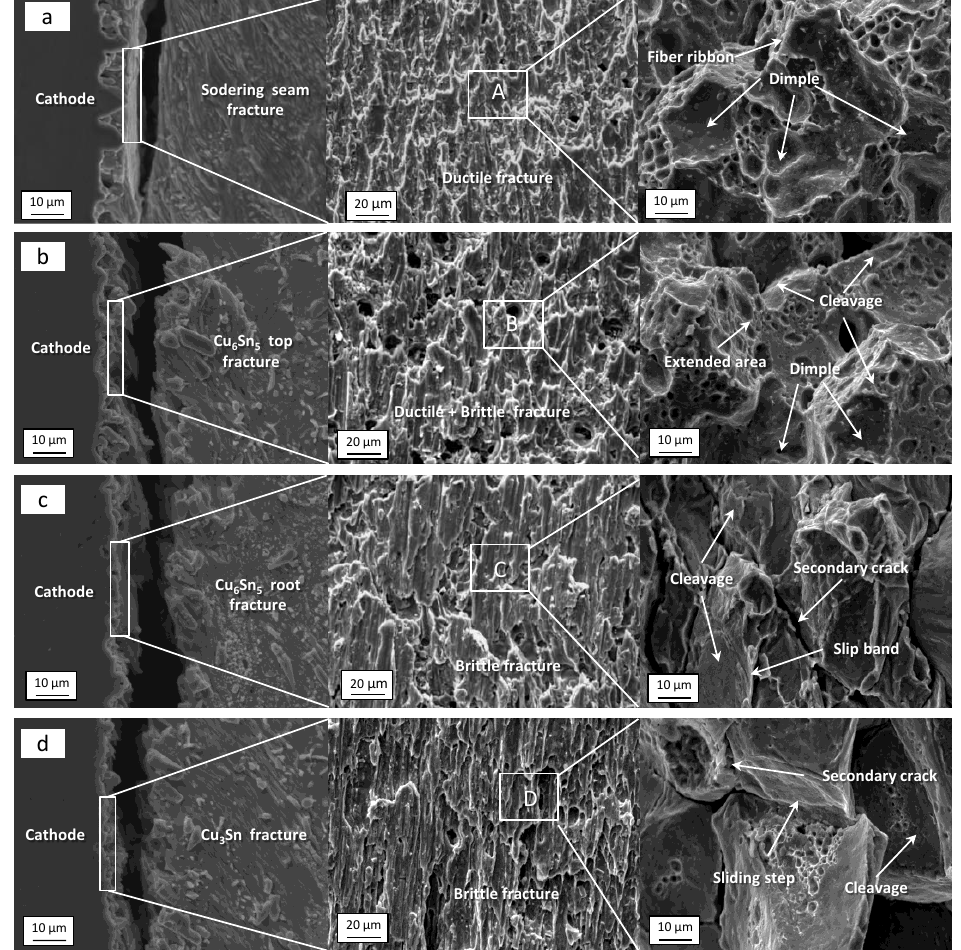
Figure 11. Shear fracture morphology of solder joints in four stages under current loading (j = 7 × 10 3 A/cm 2 ): ( a ) t = 0 – 100 h; ( b ) t = 100 – 200 h ; ( c ) t = 200 – 250 h; ( d ) t = 250 – 350 h.